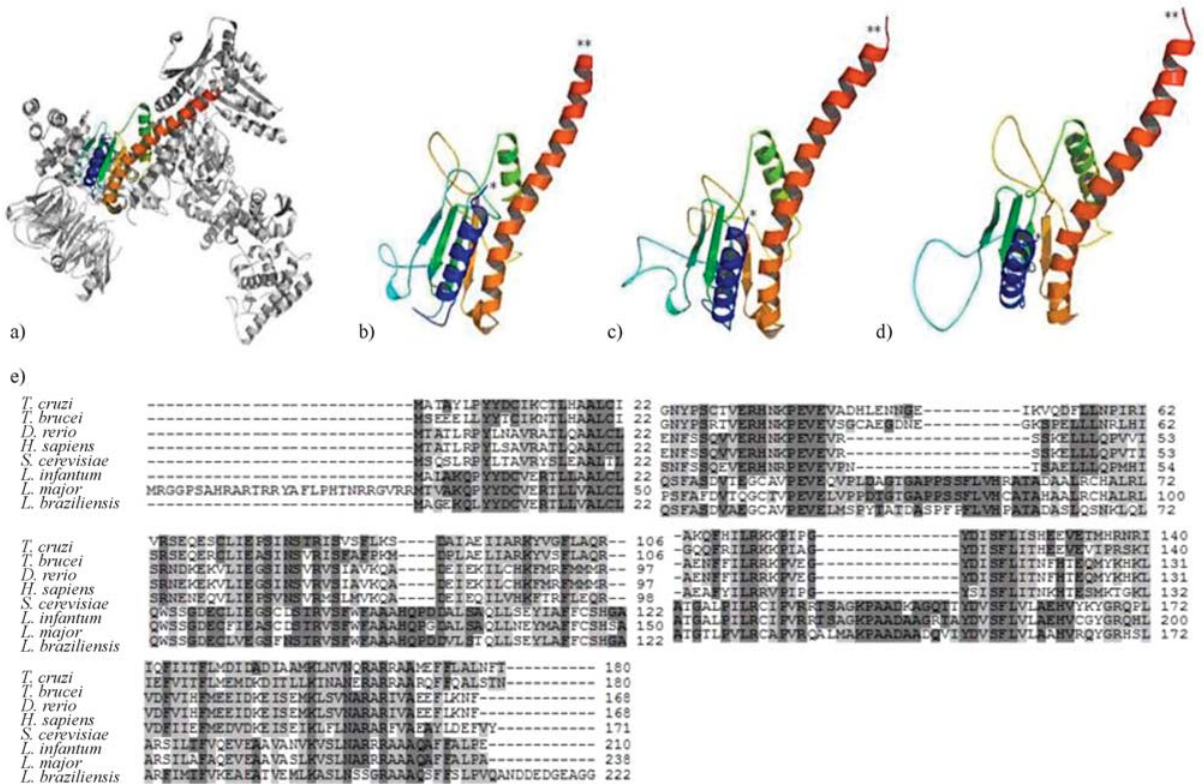
Figure 3 - 3D visualization of Arp2/3 complex modeling, including possible binding site to a coronin WDR domain at central (blue) region and multiple alignment of the amino acid sequences of Arp2/3 complex proteins from different organisms. A) PDB solved structure of Bos taurus Arp2/3 complex (1K8K) used as a template for building comparative models of Leishmania Arps with sequence from B) L. braziliensis (LbrM02.0360); C) L. infantum (LinJ02.0520) and D) L. major (XP_822258.1). *N-terminus; **C-terminus. E) Multiple alignment of the amino acid sequences of Arp2/3 complex pro- teins. Accession numbers are: T. cruzi (XP_810627.1), T. brucei (XP_951567.1), D. rerio (NP_991100.1), H. sapiens (NP_005709.1), S. cerevisiae (NP_012912.1), L. infantum (LinJ02.0520), L. major (XP_822258.1) and L. braziliensis (LbrM02.0360). Residues identical or similar are shaded dark or light gray, respectively. Dashes indicate gaps introduced for optimal